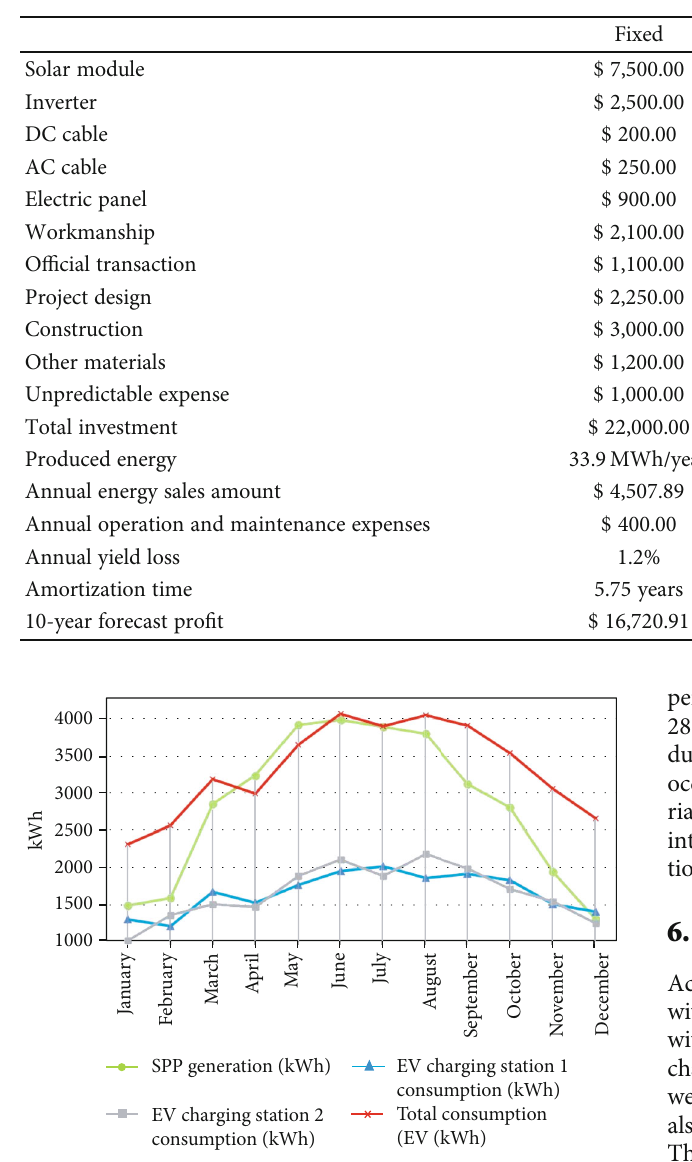
Table 3: Production costs and pro fi ts.